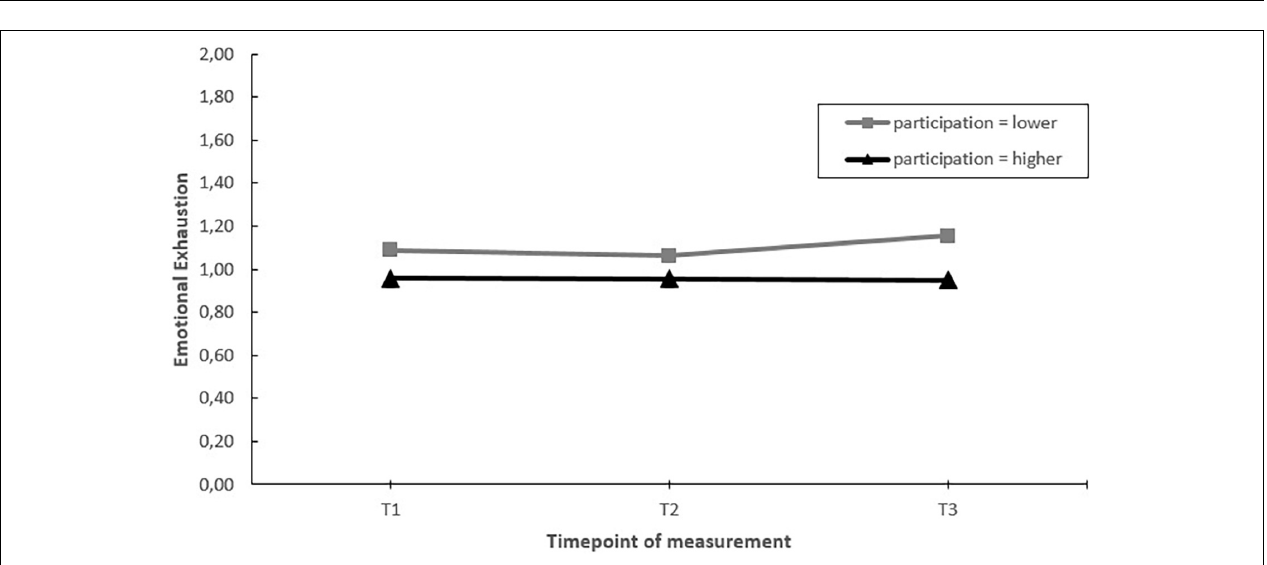
FIGURE 11 | Moderation effect of emergency departments with higher levels of employee participation versus emergency departments with lower levels of employee participation during the intervention project on changes in emotional exhaustion over time. T1 = 2017, T2 = 2018, T3 =